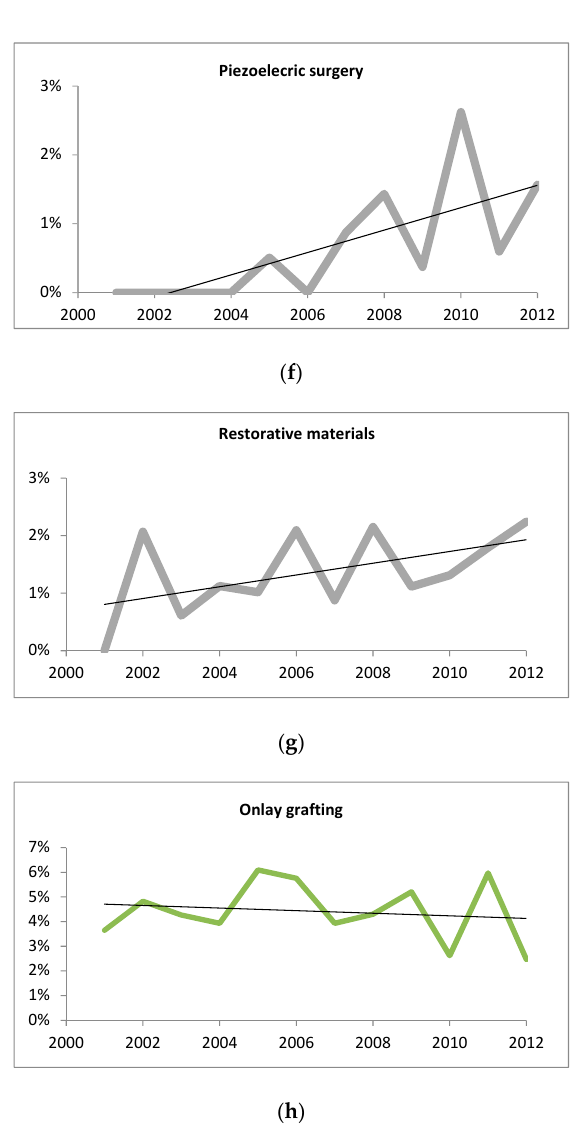
Figure 2. Trend curves (percentage out of the total number of publications per year) for ( a ) immediate loading; ( b ) platform switching; ( c ) flapless implant surgery; ( d ) guided implant surgery; ( e ) growth factors; ( f ) piezoelectric surgery; ( g )restorative materials; and ( h ) onlay grafting.